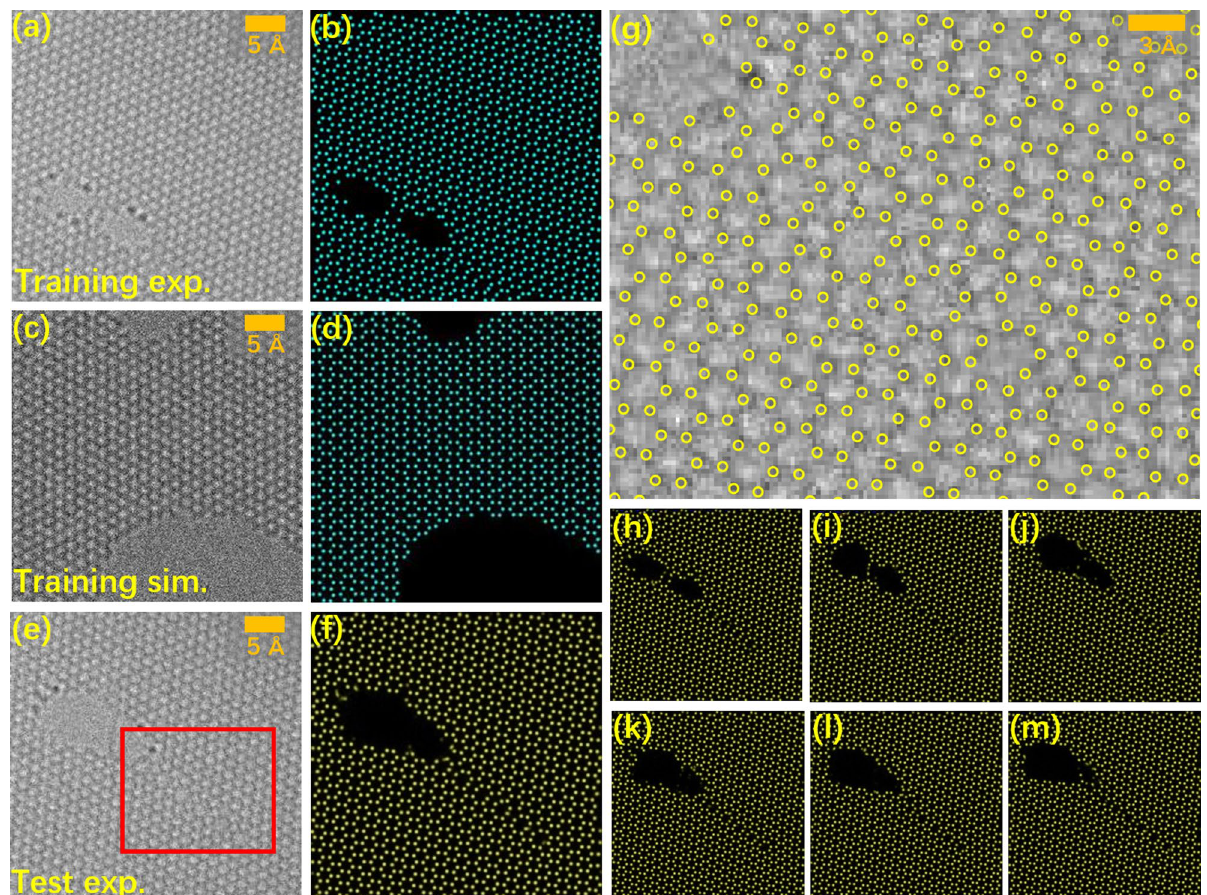
Figure 2. Predictions and their accuracy of modes trained via a mixture of simulated images and experimental images. ( a – d ) Two sets of the input–output image pairs. ( a ) An input image intercepted from one experimental image, and ( b ) the output image prepared from the atomic positions identified by using the traditional method. ( c ) A simulated input image and ( d ) the output image with atoms plotted according to its known structure. ( e ) An experimental image in the test set and ( f ) its prediction. ( g ) The region extracted from the red box in ( e ), in which the yellow circles are the positions of the atoms measured from the probability map. ( h – m ) Evolution of the line defects and the holes in graphene extracted from the ( h ) 1st, ( i ) 10th, ( j ) 15th, ( k ) 20th, ( l ) 25th and ( m ) 30th frames in this image